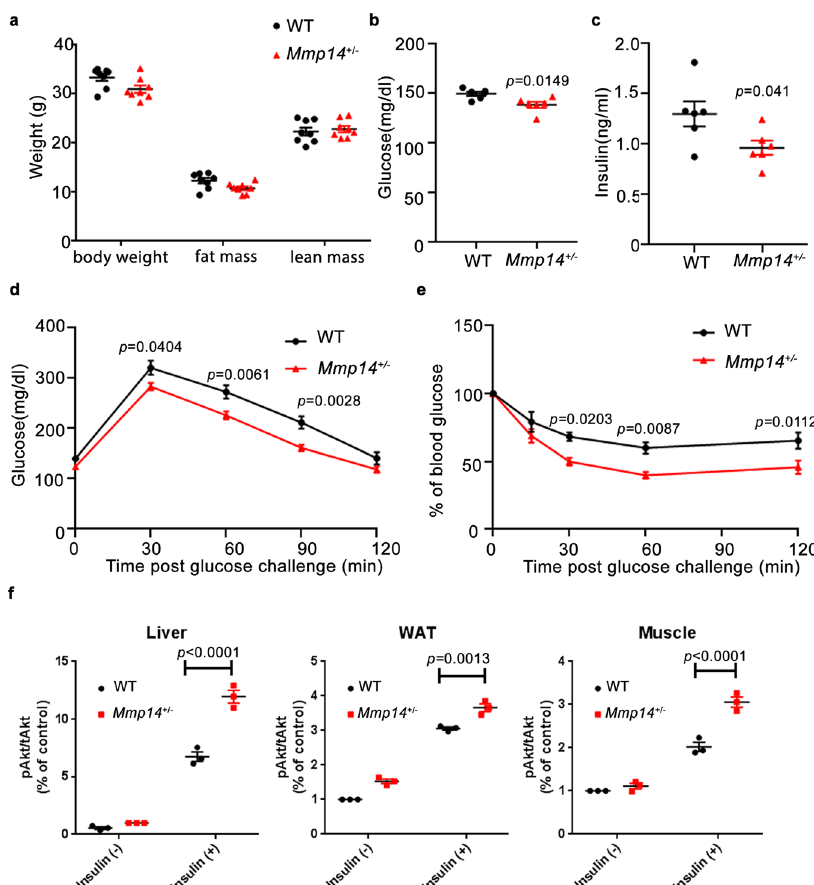
Fig. 1 Hemizygous depletion of MT1-MMP promotes insulin sensitivity in aged mice. In all, 18-months-old WT and Mmp14 + / − mice on a chow diet were compared: a body weight and composition ( n = 6), b fasting plasma glucose ( n = 6), c fasting plasma insulin ( n = 6), d glucose-tolerance test ( n = 6), e insulin-tolerance test ( n = 6), f WT and Mmp14 + /- mice fed chow diet at the age of 18 months were challenged with insulin. The expression of phosphorylated Akt (pAkt) in relative to the level of total Akt (tAkt) in the livers, white adipose tissues (WAT) and muscles was examined by western blotting and quanti fi ed. ( n = 3) Representative western blots were shown in Supplementary Fig. S4D. Data are reported as average ± s.e.m.; two-sided unpaired t test ( a – c ) one-way ANOVA ( f ) or two-way ANOVA ( d , e ). Source data are provided as a Source Data fi